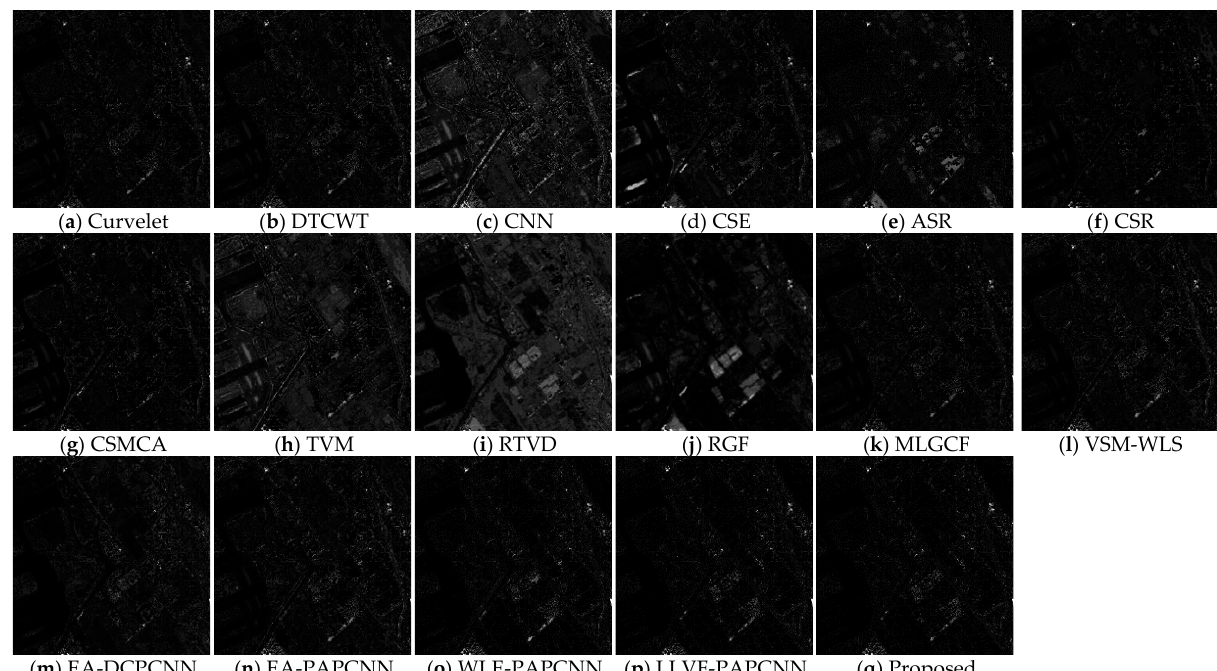
Figure 8. Error images corresponding to SPOT-6 images.